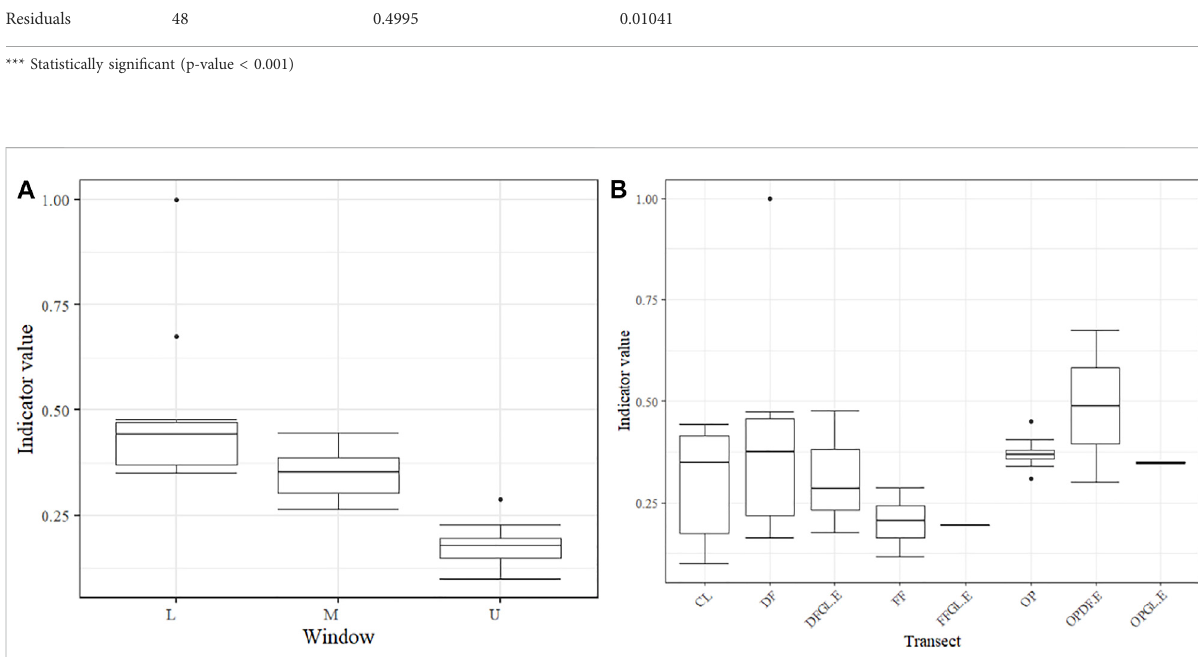
FIGURE 5 Soil ES indicator of fertility ESPU. (A) . Window. (B) . Transects. Orotoy river basin. FF, Fragmented Forest; DF, Tropical Dense Humid Forest; GL, Cattle Grassland; OP, Oil Palm Plantation. DFGL.E, ecotone DF-GL; OPDF.E, ecotone DF-OP; OPGL.E, ecotone OP-GL; FFGL.E, ecotone FF-GL. Source: Elaborated by the